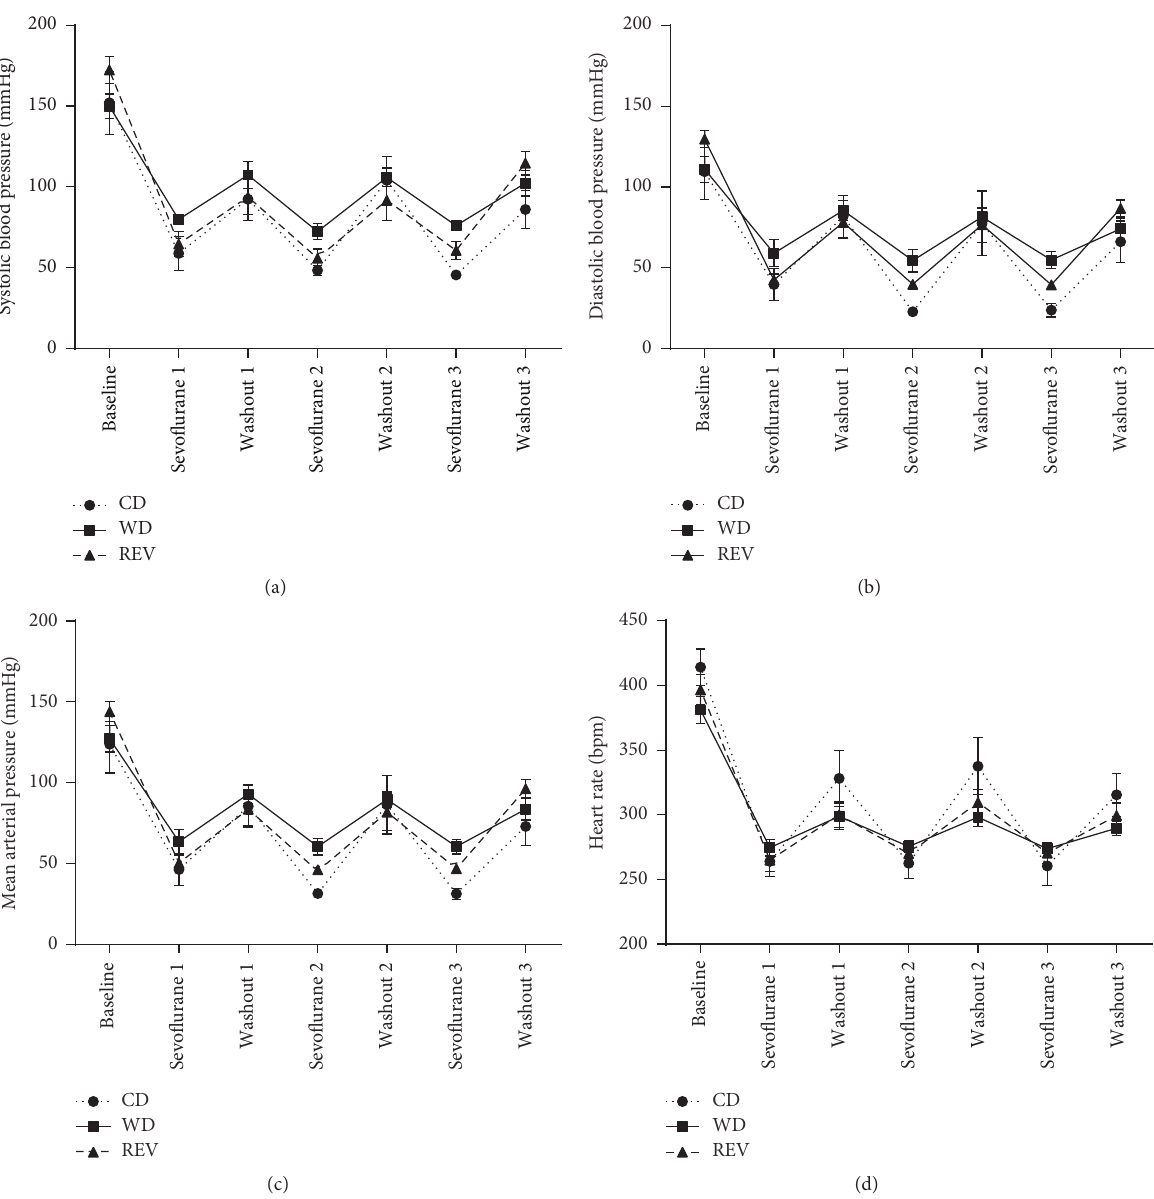
Figure 5: Effect of sevoflurane on hemodynamics. Systolic blood pressure (a), diastolic blood pressure (b), mean arterial pressure (c), and heart rate (d) at baseline and after 3 × 5 -minute exposure to sevoflurane with 3 × 5 -minute washout periods in between in rats after 8 weeks of control diet (CD), western diet (WD), or reversion diet (REV) feeding. Data are mean ± SD, 𝑛 = 7